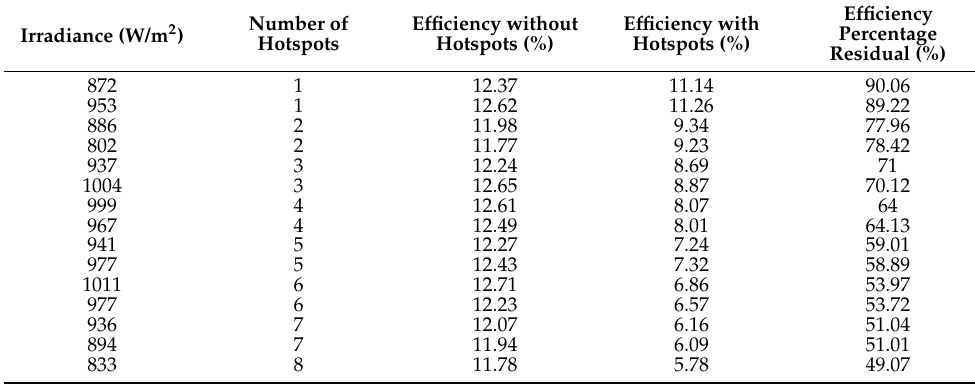
Table 8. Measured data of hotspot number and residual